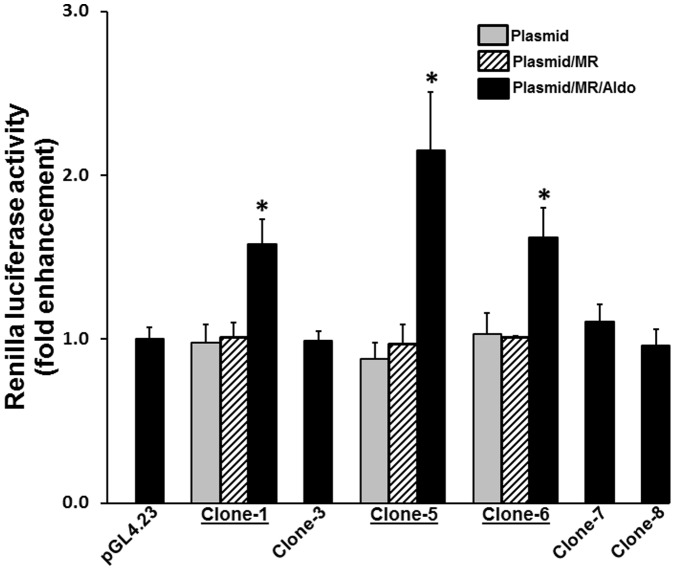
Effect of aldosterone and cortisol concentrations on luciferase activity in mineralocorticoid receptor (MR) and Kcnn4 genomic clones (clone-1, -5 and -6) transfected HEK293T cells.HEK293T cells were transfected with either MR and a vector (pGL4.23) or MR and the respective Kcnn4 genomic clone (clone-1, clone-5 or clone-6). Increasing concentrations (0–100 nM) of either aldosterone or cortisol were determined on luciferase activity. Clone numbers (1, 5 and 6) are indicated to the right. The pGL4.23 transfected cells were unresponsive to both hormones up to 100 nM (data not shown). Murine Mammary Tumor Virus (MMTV) transfected cells exhibited greater than a 30-fold increase in luciferase activity for both hormones with an EC50 of approximately 1 nM (data not shown). Fitted curves shown were obtained using Graphpad Prism 4 regression analysis software.